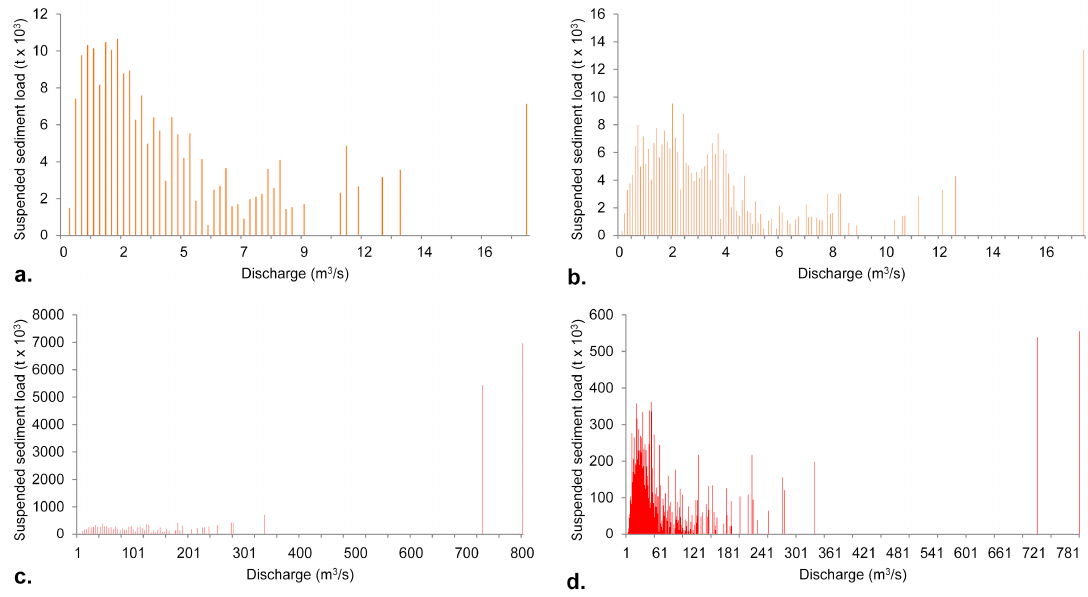
Figure 7. Load histograms for Trotu ș River at Lunca de Sus: ( a ) SD/4 method—78 classes; ( b ) EBM method—175 classes and Târgu Ocna; ( c ) KDE method—200 classes; and ( d ) RSSL method—800 classes.